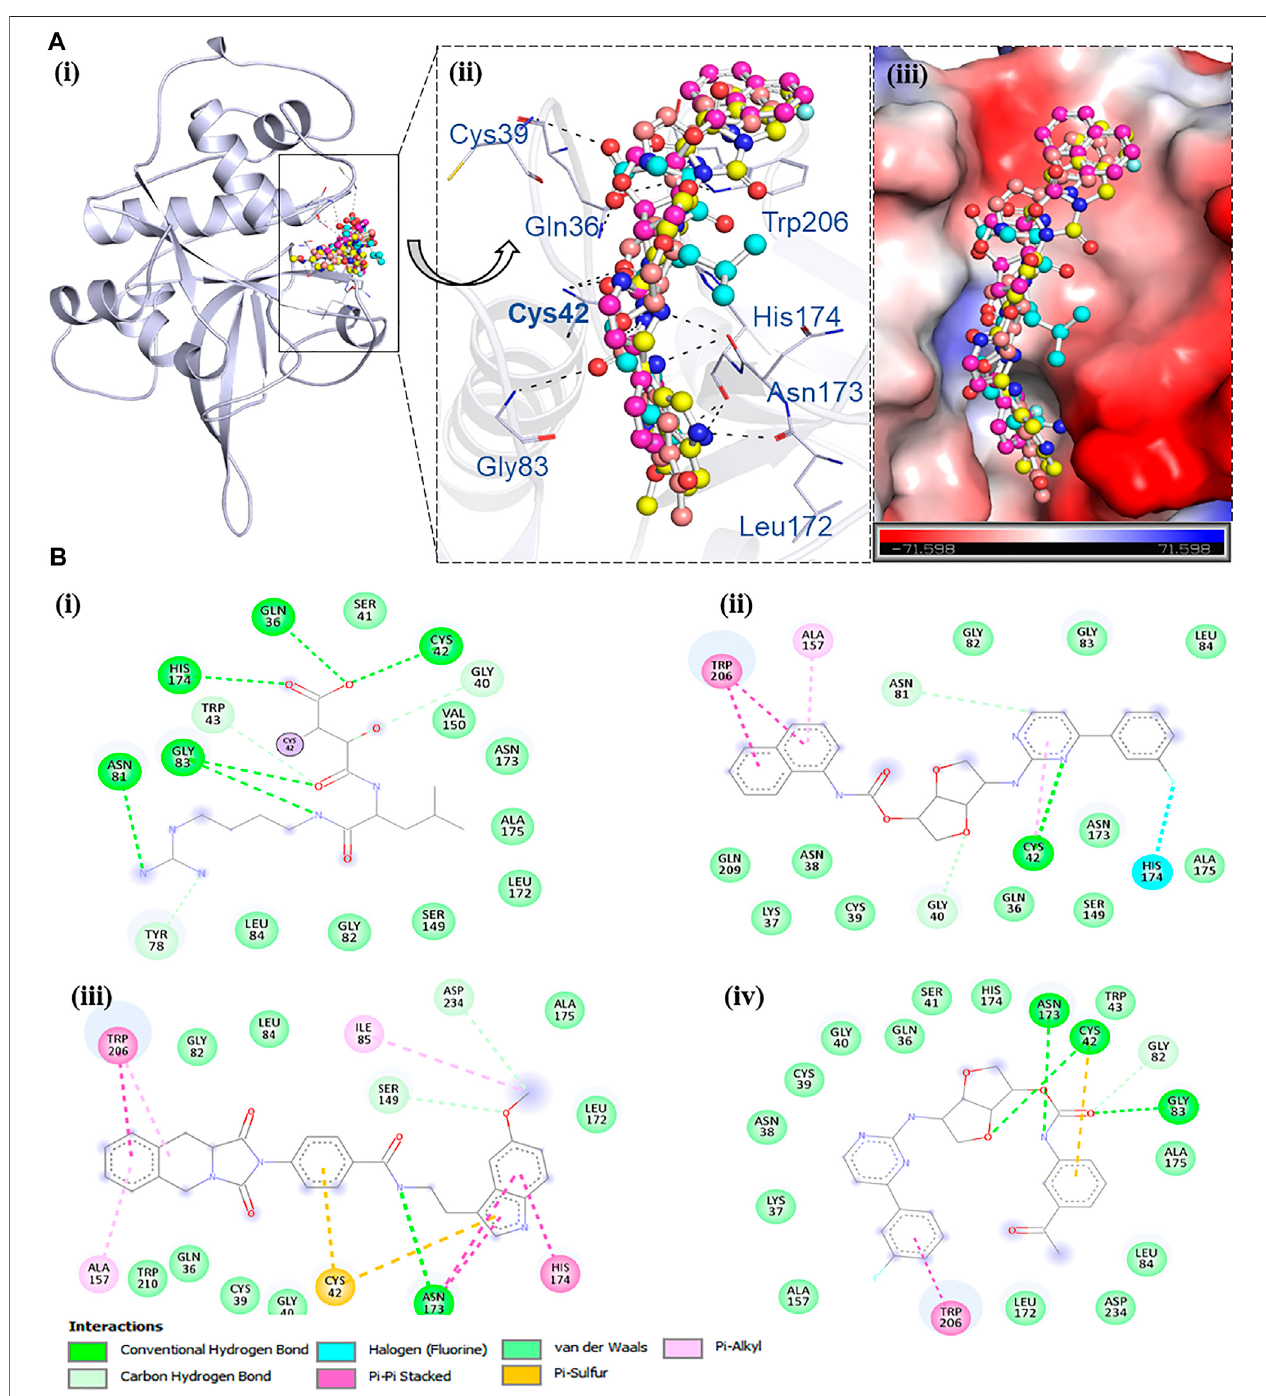
FIGURE 1 | Structural representation of FP2 complexed with NT23, ST72, NT18, and E64. ( A (i) ) Representation of the cartoon structure of FP2 with the lead compounds.(A(ii))ZoomedviewindicatingtheinteractionofFP2withE64(cyan),NT23(magenta),ST72(yellow),andNT18(red).(A(iii))SurfacepotentialviewoftheFP2 pocket occupied by the selected compounds and the electrostatic potential was generated using PyMOL. (B) Two-dimensional structural representation of binding pocket residues of FP2 and their interactions with (B (i)) E64, (B (ii)) NT23, (B (iii)) ST72, and (B (iv)) NT18.